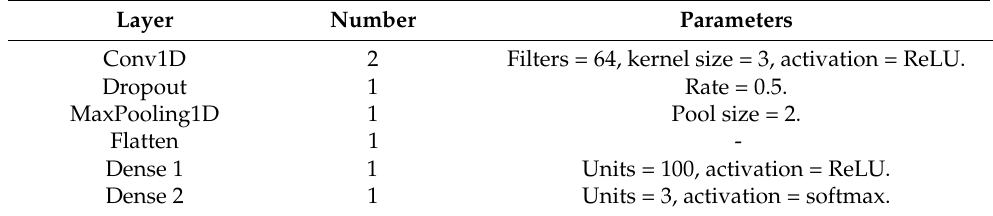
Figure 9. Pseudocode of the training process. Table 10. Proposed neural network architecture.